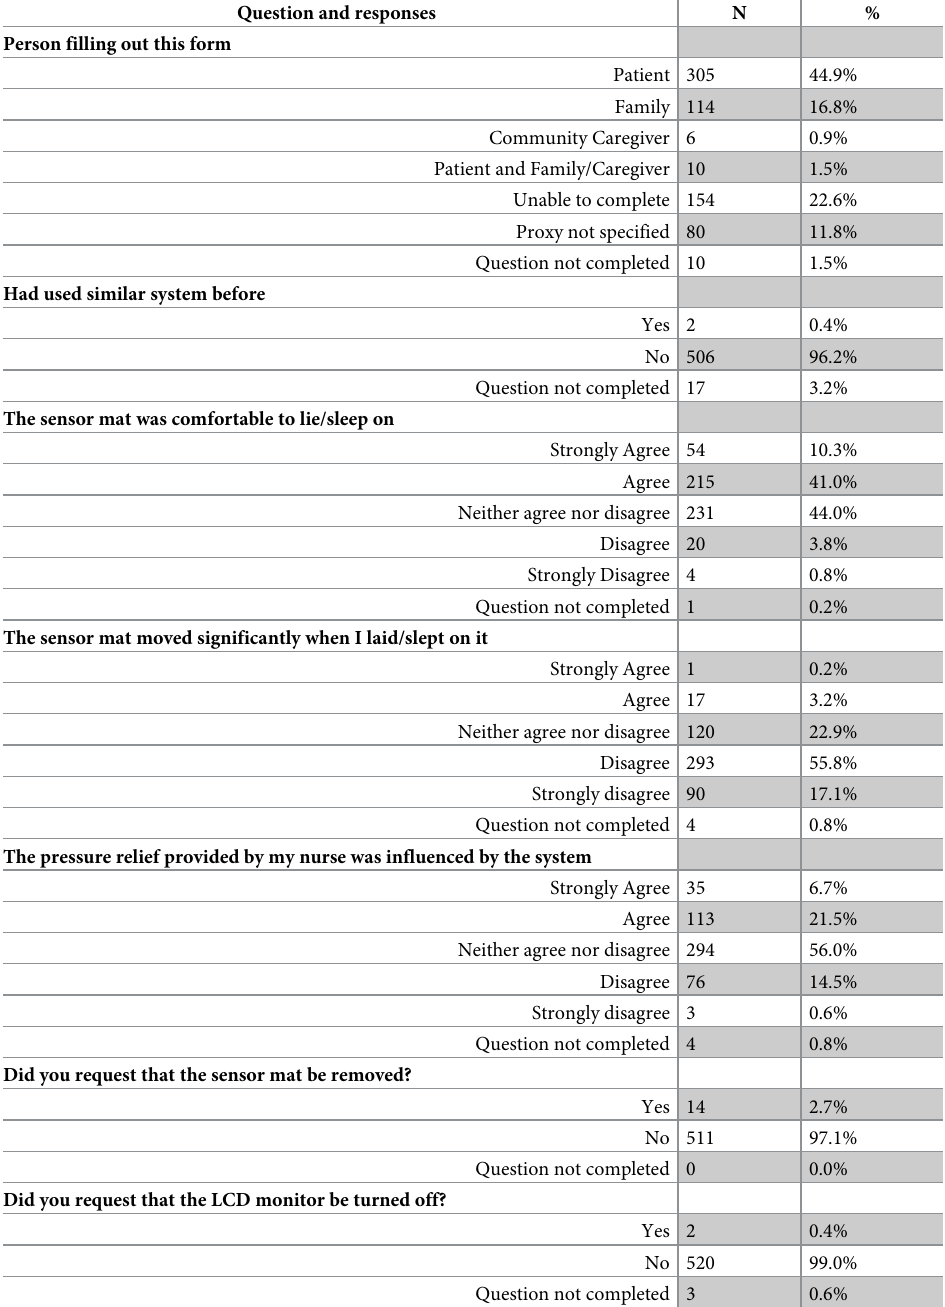
Table 3. Responses to multiple choice questions of patient/family/caregiver